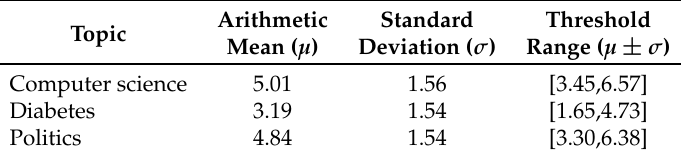
Table 8. Threshold range by